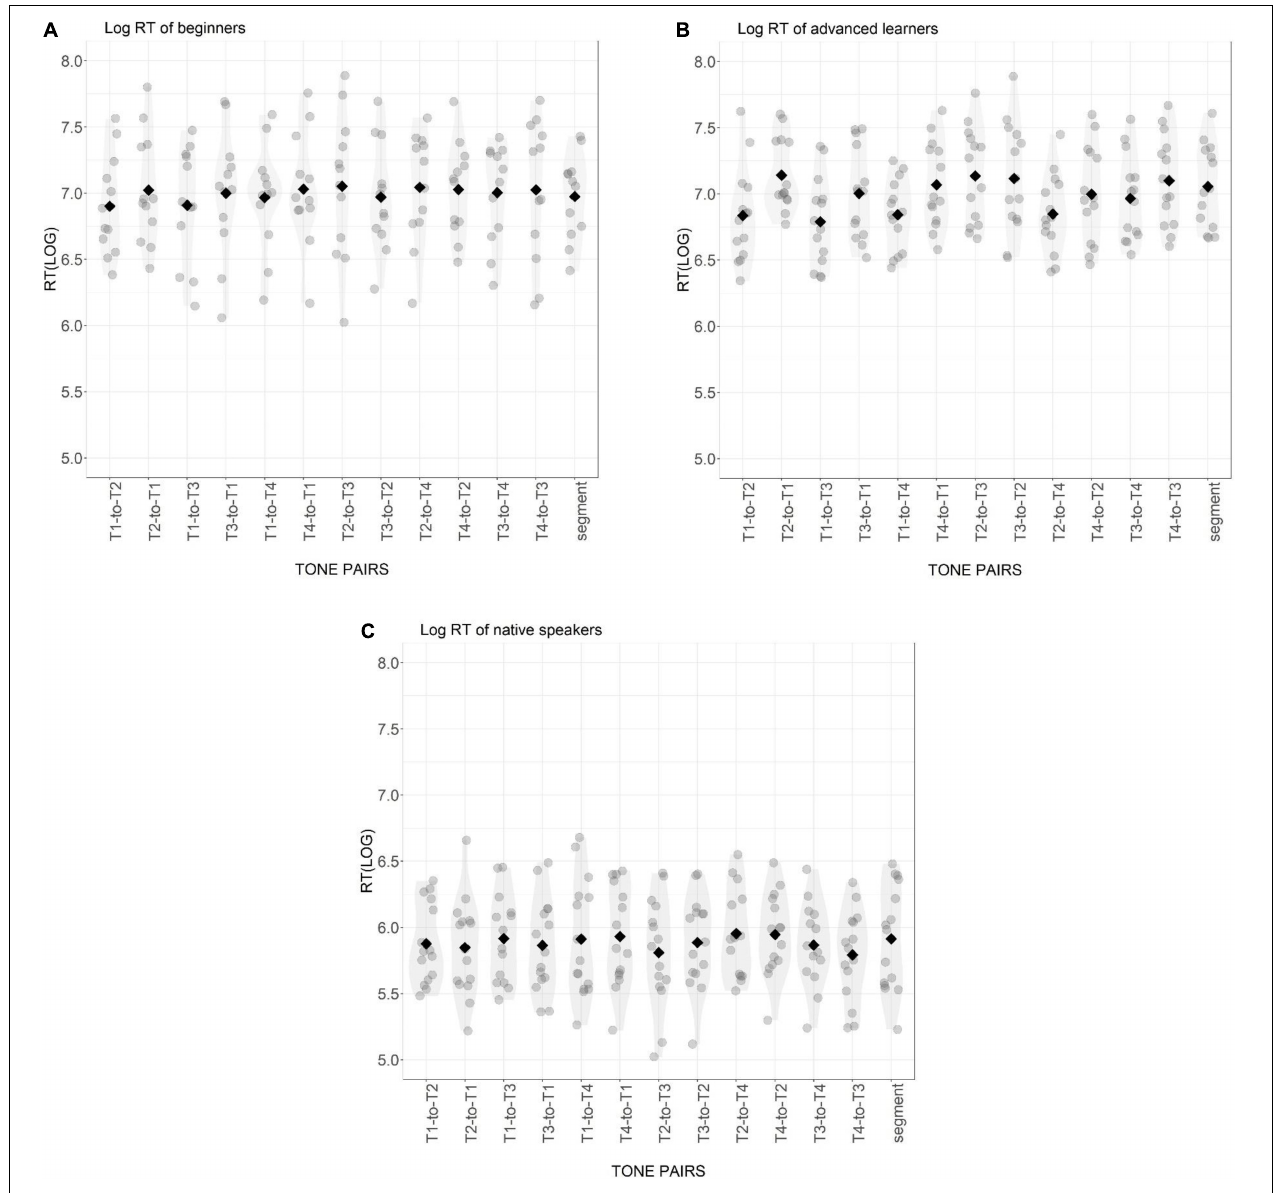
FIGURE 3 | Distribution of log-transformed reaction time of beginning learners (A) , advanced learners (B) , and native Mandarin speakers (C) for 12 tone pairs and the segmental condition. Gray points are individual participant means. Black diamonds are condition